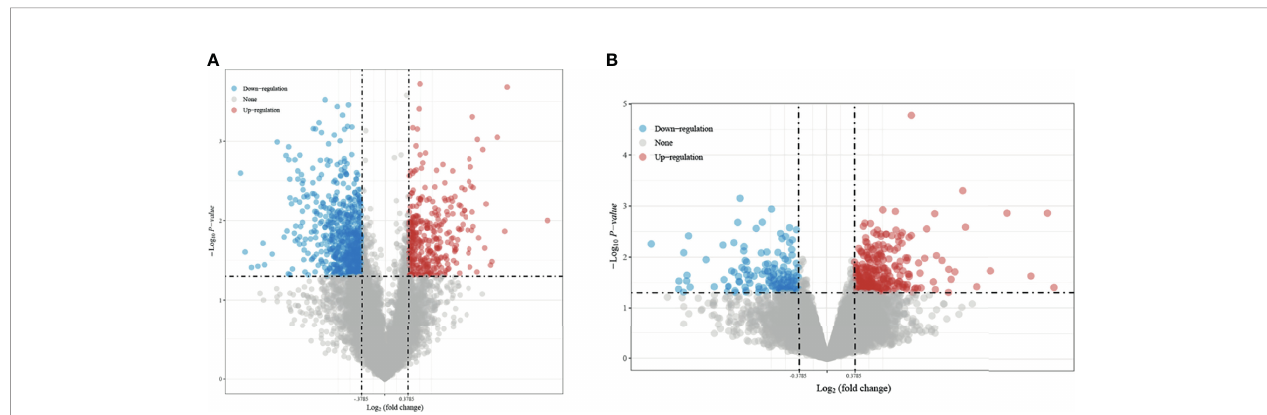
FIGURE 1 | Screening results of the differentially expressed genes (DEGs). (A) intersecting genes in TCGA and GSE6791. (B) Screened from the differential genes in The Cancer Genome Atlas